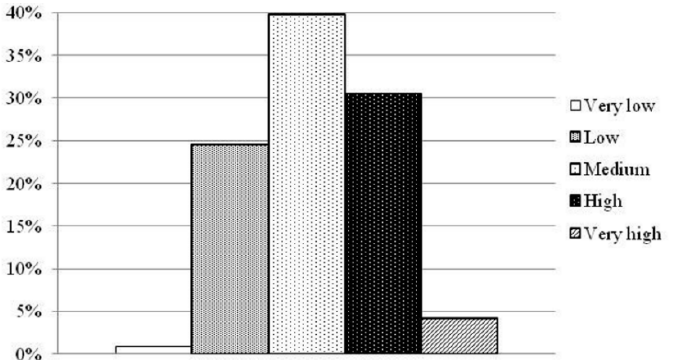
Figure 14. Distribution of the classes of integrated vulnerability of illegal dumpsite (“scores and weights”